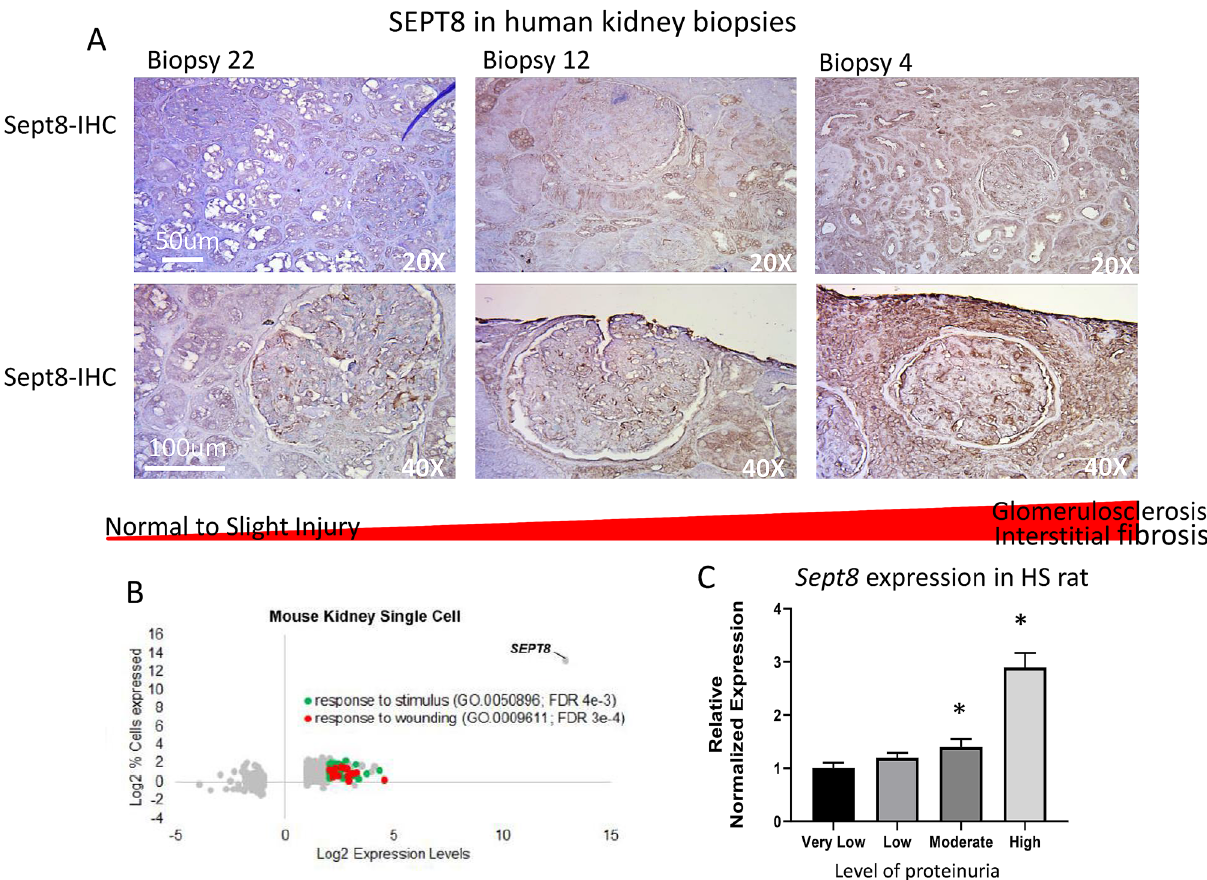
Figure 6. SEPTIN8/ Sept8 expression increases under conditions of fibrosis or wounding. ( A ) Immunohistochemistry of SEPTIN8 in human biopsies. Results are shown from three separate biopsies with varying levels of tubulointerstitial injury ranging from none (biopsy 22) to moderate (biopsy 12) to severe (biopsy 4). The top panel provides representative low resolution (20X) image of the tubule/interstitial region. The bottom panel provides an independent representative high resolution image (40X) of a single glomerulus. ( B ) Interrogating mouse single-cell databases demonstrates very high levels of Sept8 in response to stimulus or wounding and ( C ) HS rats with high levels of UPE exhibit significantly increased levels of Sept8 relative to HS rats with low to moderate urinary protein levels. rt-qPCR was run in all HS rats that were selected for histological analysis as described in Fig. 1. * p < 0.05 vs very low, † p < 0.0001 vs all